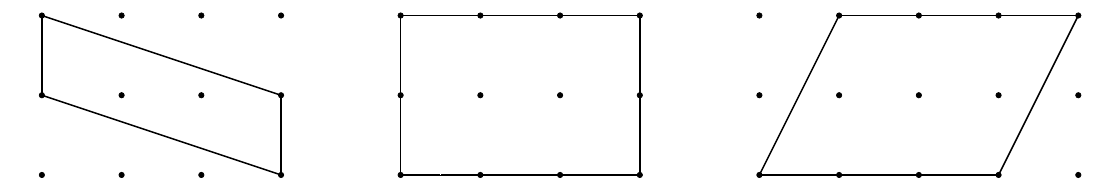
Figure 1 . From left to right Newton polygons for: Toda chain on three sites, gl on three sites, gl spin chain on three sites with cyclic twist 2